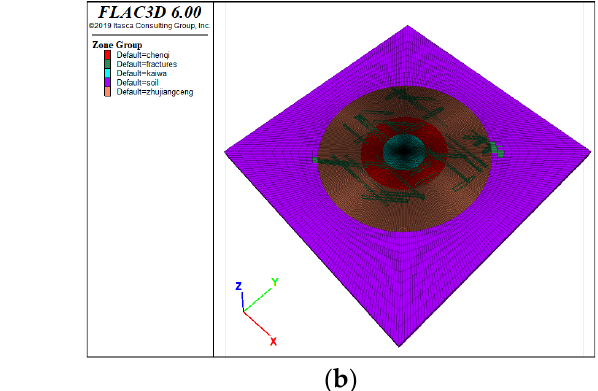
Figure 13. Dual ‐ medium model diagram of two sections. ( a ) S1ZK0 + 660 m; ( b ) S1ZK0 + 735 m.